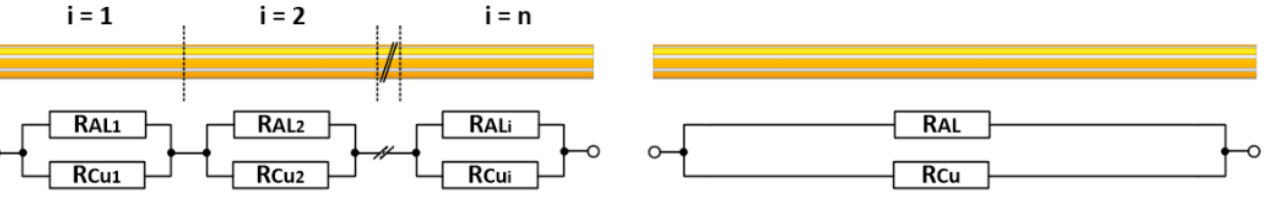
Figure 4. Schematic depiction of series and parallel circuits.